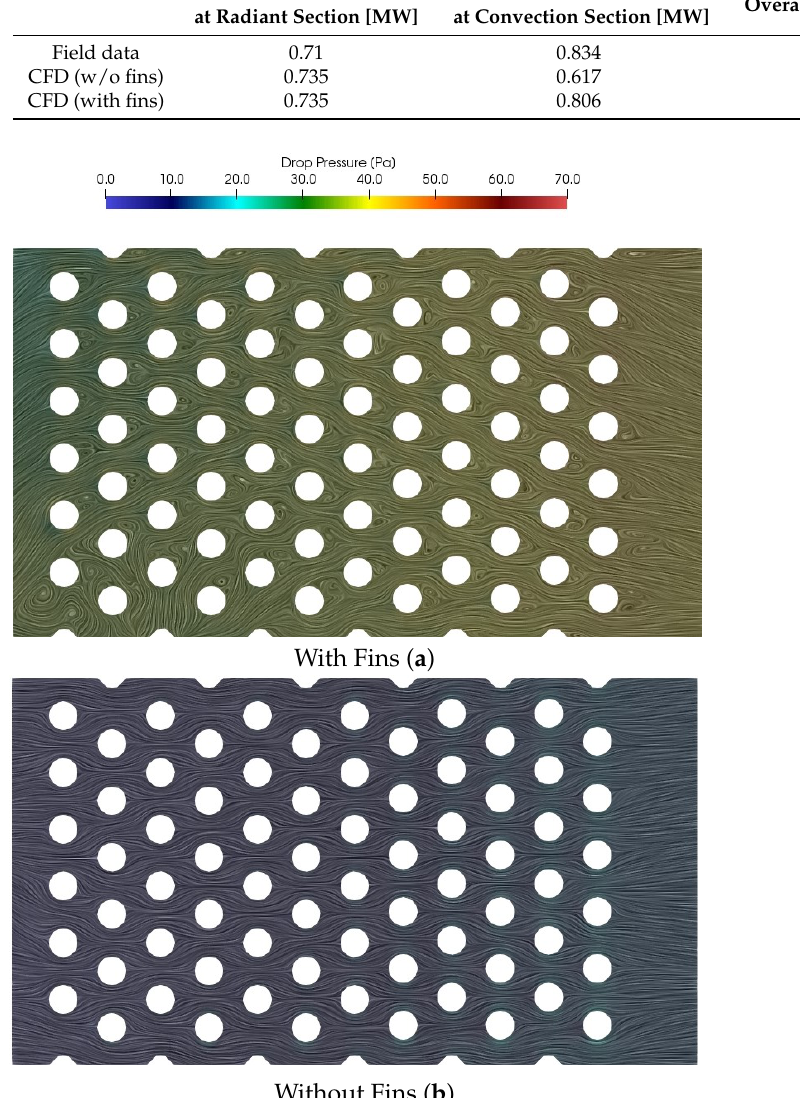
Figure 16. Flue gas streamlines with drop pressure contour profile on the convention box with ( a ) and without fins ( b ) on Second